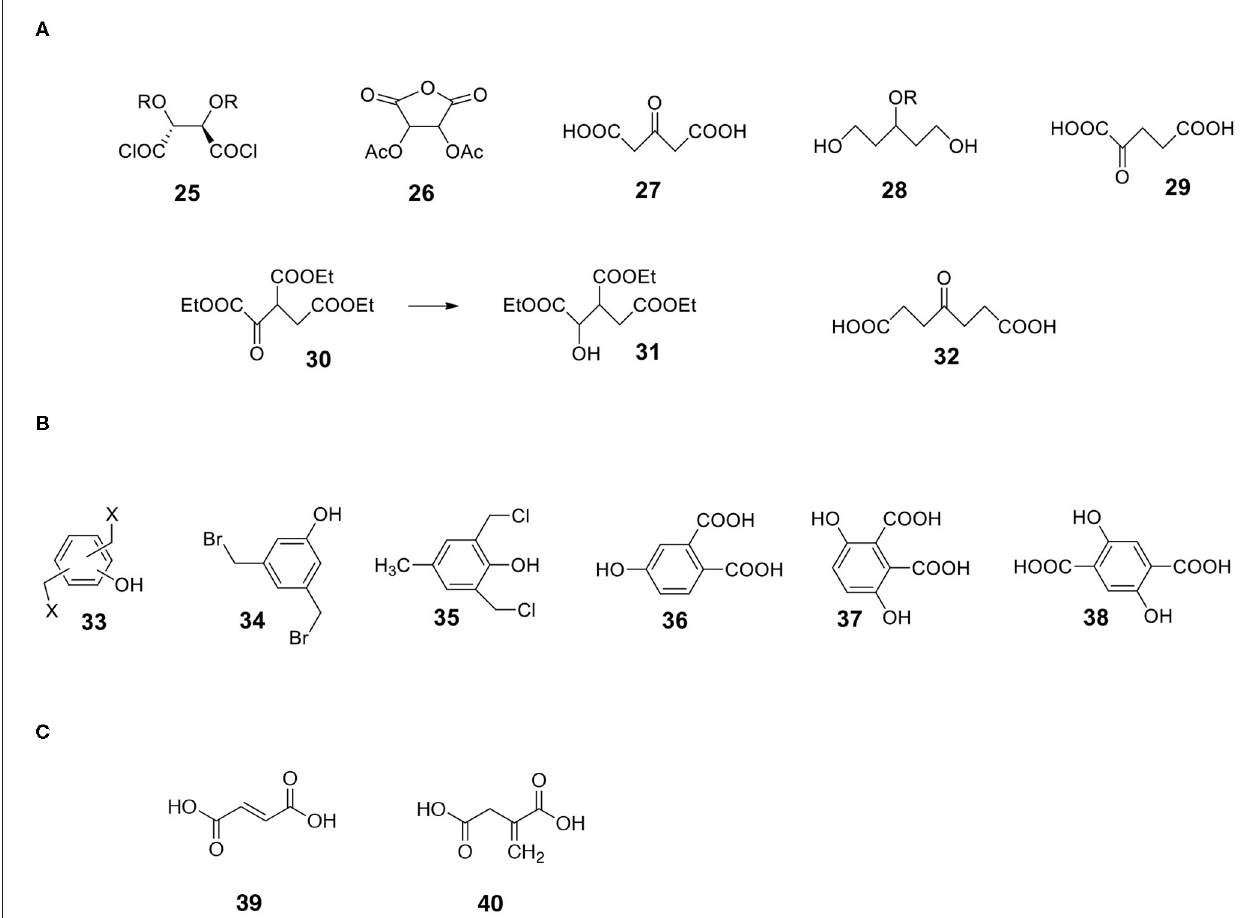
FIGURE 9 | Structures of useful derivatives of aliphatic diacids and bifunctional aromatic compounds. (A) Aliphatic diacids. (B) Aromatic bifunctional compounds. (C) Unsaturated